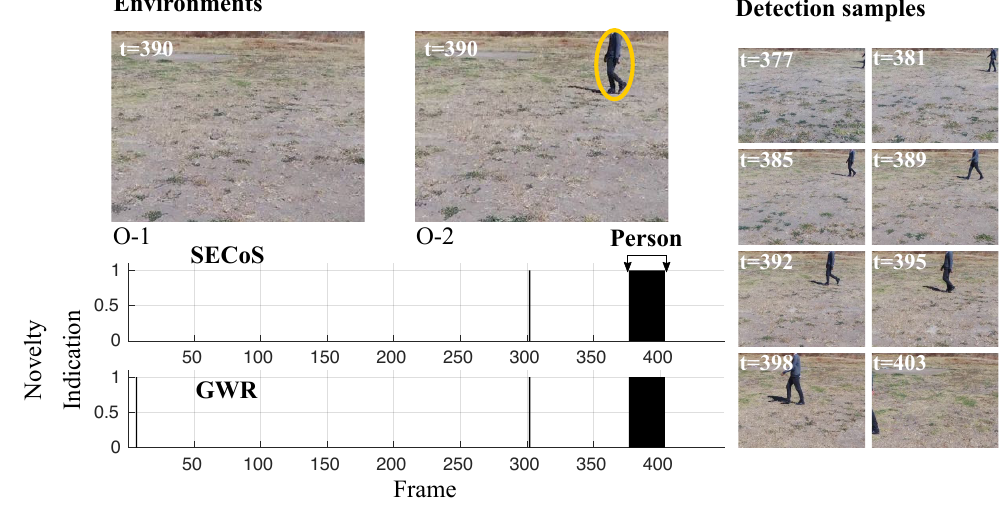
Figure 14. Visual results in novelty detection on dataset D-1, with the person as the novel